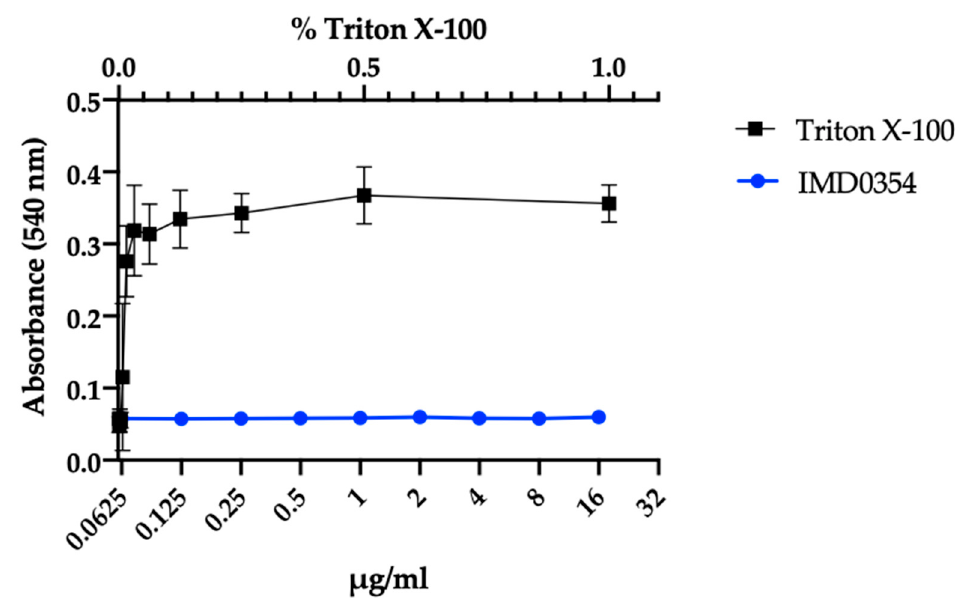
Figure 5. IMD0354 does not show hemolytic activity. Human red blood cells were incubated with serially diluted IMD0354 (0.0156–16 µ g / mL) and normalized to hemolysis of 1% Triton-X 100. Each sample was tested in triplicate ( n = 3, ± S.D).